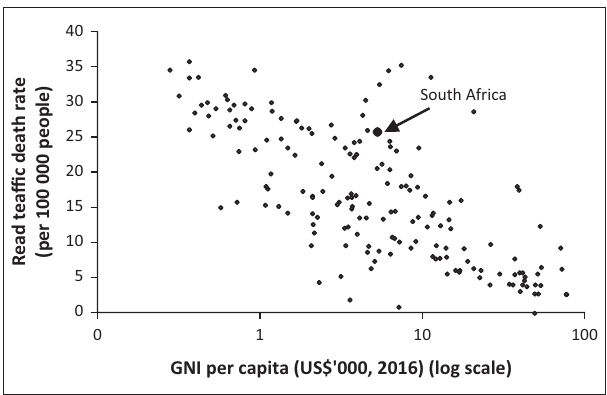
GNI, Gross national income. FIGURE 2: Road traffic deaths per 100 000 of the population